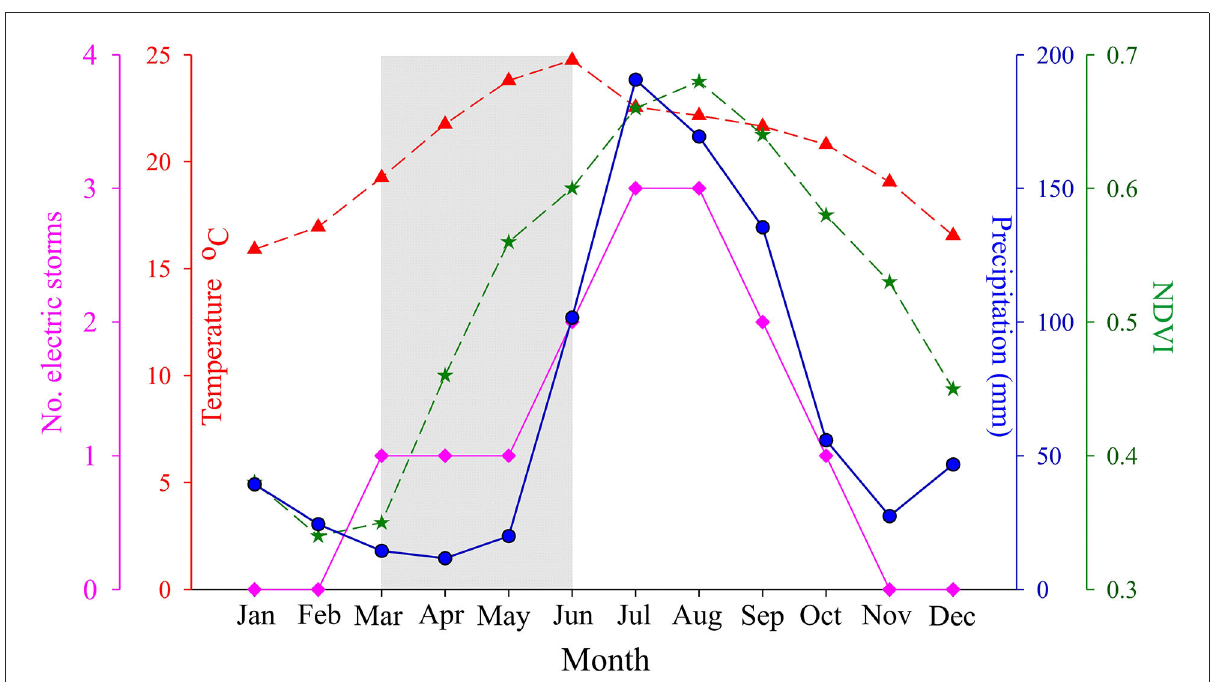
FIGURE6 Monthly average precipitation (blue circle solid line), temperature (red triangles dashed line), lightning activity (pink squares solid line) and normalized difference vegetation index (NDVI) (green stars dashed line). Variables are average values recorded from 1951 to 2010 at weather stations close to our P. lumholtzii forest site [Servicio Meteorológico Nacional (SMN), 2017]. Values of NDVI indicate the photosynthetic rate of the vegetation or the level of vegetation stress. The NDVI values are monthly averages for the period 1981–2006 for the vegetation (Tucker et al., 2005). The gray highlighted areas indicate the spring period when most fires historically